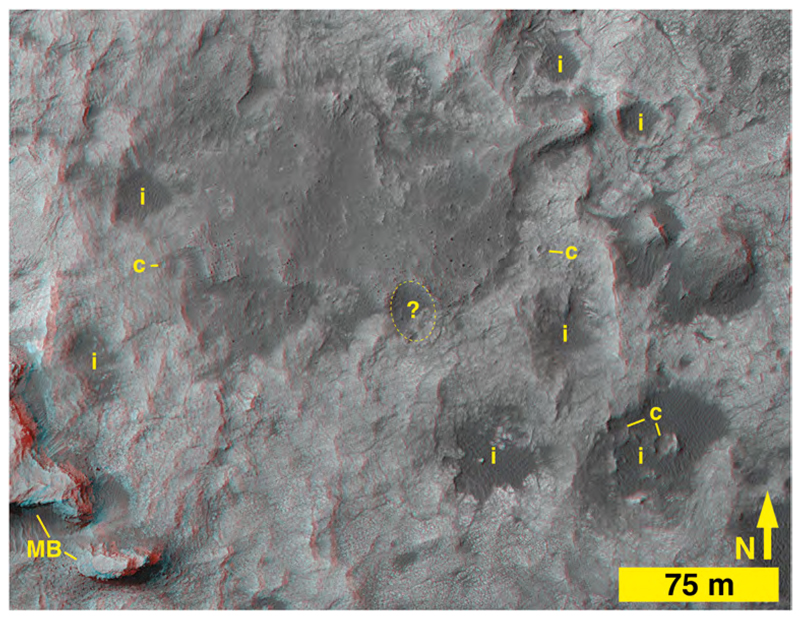
Stereo pair anaglyph of Bimbe (large, dark-toned patch) and its vicinity. Most of the boulders observed at Bimbe occur on the elevated portions of the south margin of Bimbe. The feature within the dashed ellipse, indicated with a “?,” might be the eroded remains of an impact structure. Definitive impact craters are labeled with “c” and probable impact structures are labeled with “i”. Dark-toned eolian sand, expressed as bedforms, has collected in the impact structure depressions. Features labeled “MB” are a couple of the Murray buttes. (Anaglyph will only appear in 3D on the web version of this article.)